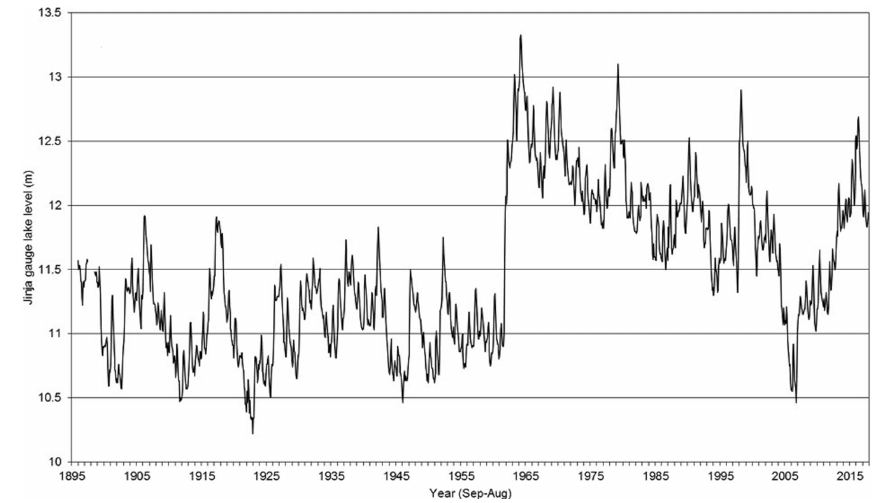
Figure 2. Lake Victoria water levels from 1896 to 2017 (source: NCSU et al.,